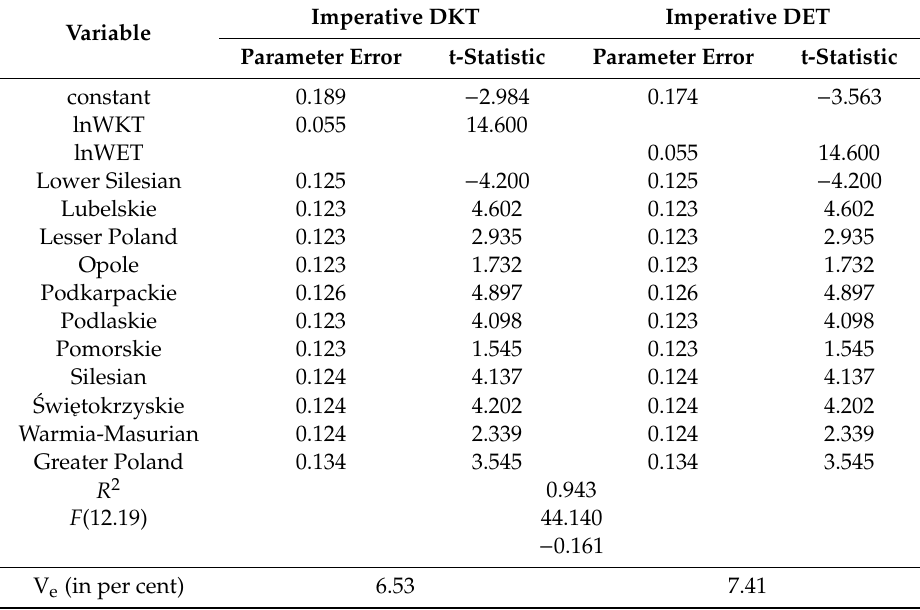
Table 3. Values of the decomposed intercepts after undoing the logarithm in imperative DLT. Imperative DKT Imperative DET Variable Parameter Error t-Statistic Parameter Error t-Statistic constant